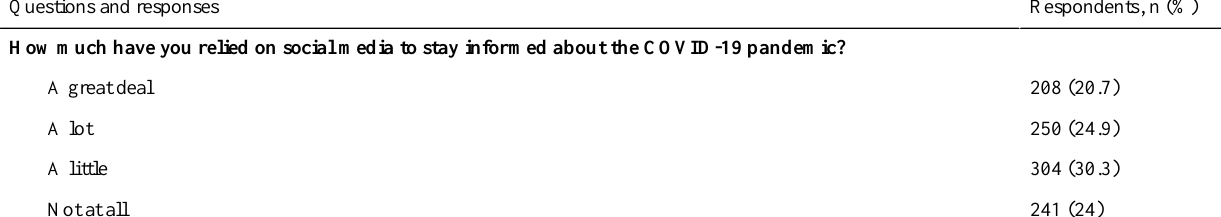
Respondents, n (%)Questions and